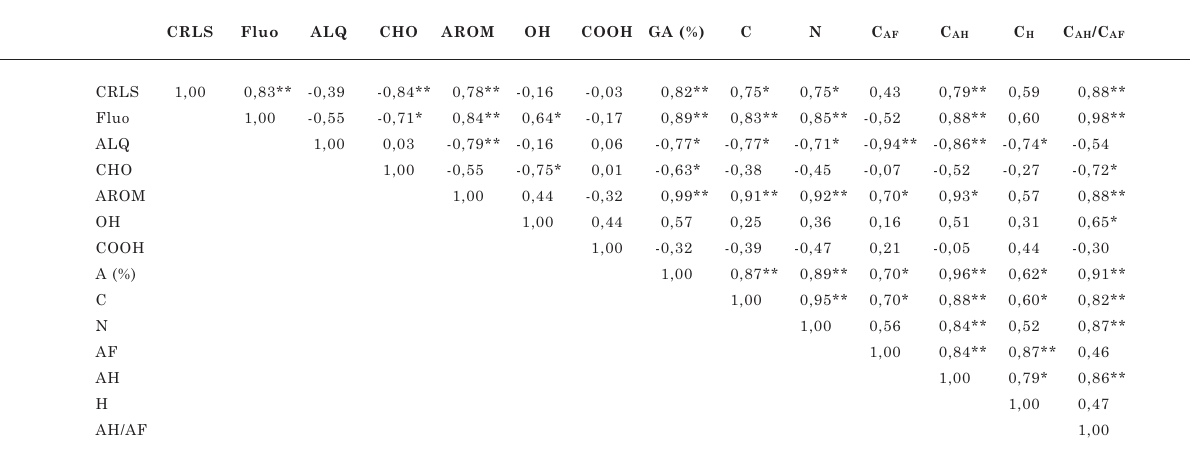
(1) Variáveis obtidas da fração ácidos húmicos: CRLS = concentração de radicais livres do tipo semiquinona; Fluo = intensidade de emissão de fluorescência com excitação fixa em 465 nm. Variáveis obtidas da MOS: ALQ = C alifático; CHO = C polissacarídeos; AROM = C aromático; OH = C fenólico; COOH = C carboxílico; GA(%) = grau de aromaticidade; C e N = estoque de C e N; C = estoque de C na fração ácidos fúlvicos; C = estoque de C na fração ácidos húmicos; C = estoque de C na fração humina. AF AH H ** e * = correlação significativa a 1 e 5 %,